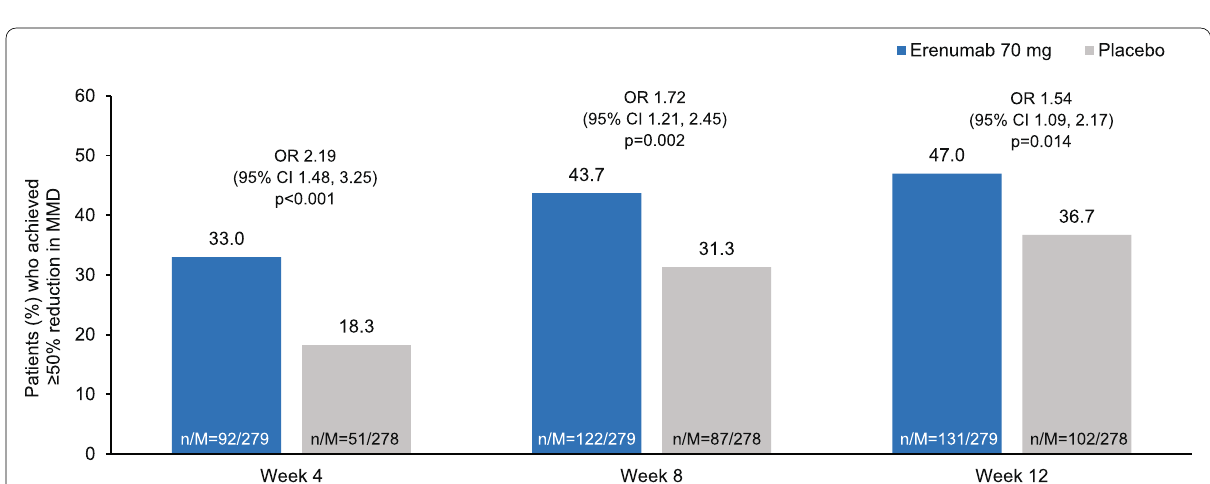
Fig. 3 Proportion of patients achieving 50% reduction from baseline in MMD (Full Analysis Set). P ‑values reported for the dichotomous secondary ≥ endpoint (proportion of patients achieving 50% reduction in MMD) are nominal and should be interpreted with caution. n, number of patients ≥ who achieved 50% reduction in MMD; M, total number of patients in the treatment group with response variable defined. Note: Statistical analysis ≥ for the proportion of patients with 50% reduction from baseline in MMD was done using CMH test adjusting for stratification factor after missing ≥ data was imputed (NRI). CI, confidence interval; CMH Cochran–Mantel–Haenszel; MMD monthly migraine day; NRI non‑responder imputation;